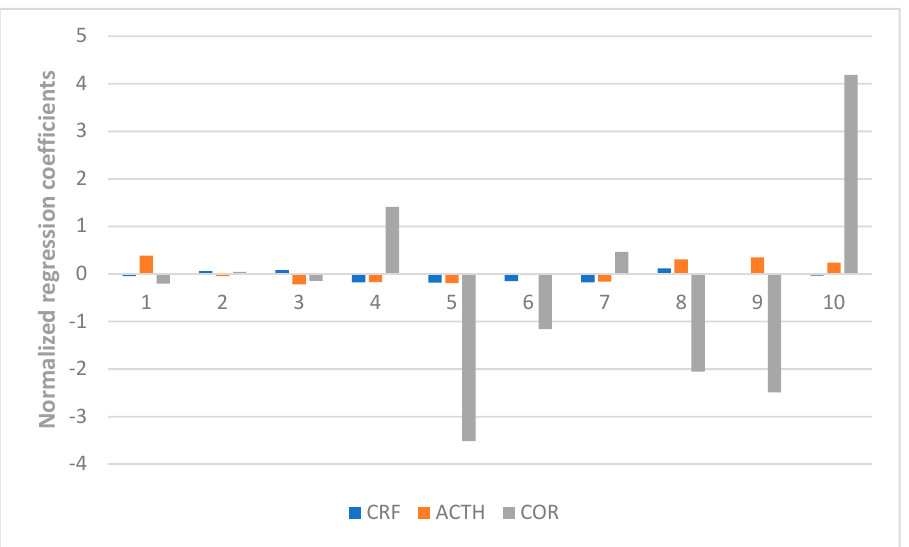
Figure 6. Normalized regression coefficients between the contents of the 10 ZZX samples and the values of the pharmacodynamic behavioral indices. 1 : Neochlorogenic acid, 2 : Chlorogenic acid, 3 : Cryptochlorogenin acid, 4 : Isochlorogenic acid B, 5 : Isochlorogenic acid A, 6 : Hesperidin, 7 : Isochlorogenic acid C, 8 : Unknown compound X, 9 : Unknown compound Y, 10 : Unknown compound Z. The regression coefficients were combined with the indices of the antianxiety effect, of which the regression coefficients of OE%, OT%, number of central entries and time spent in central areas were either positive, indicating a positive effect on antianxiety effect; or negative, indicating a negative effect on the antianxiety effect.